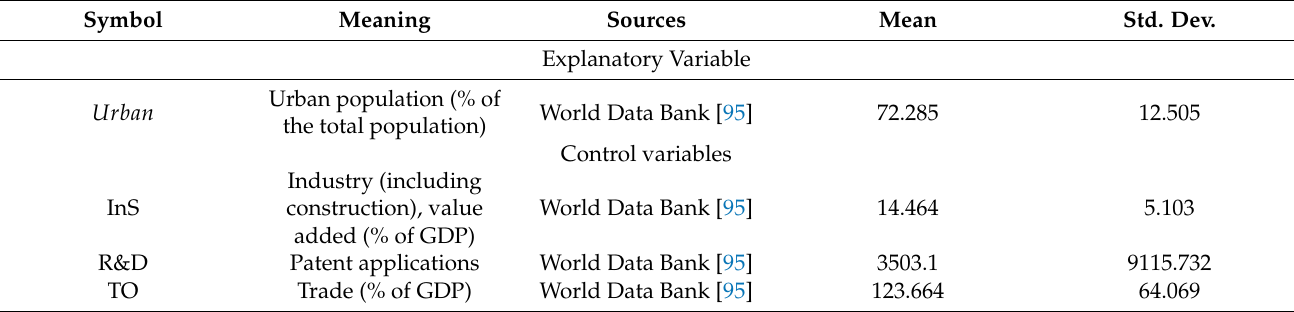
Table 2. Explanatory and control variables for regression